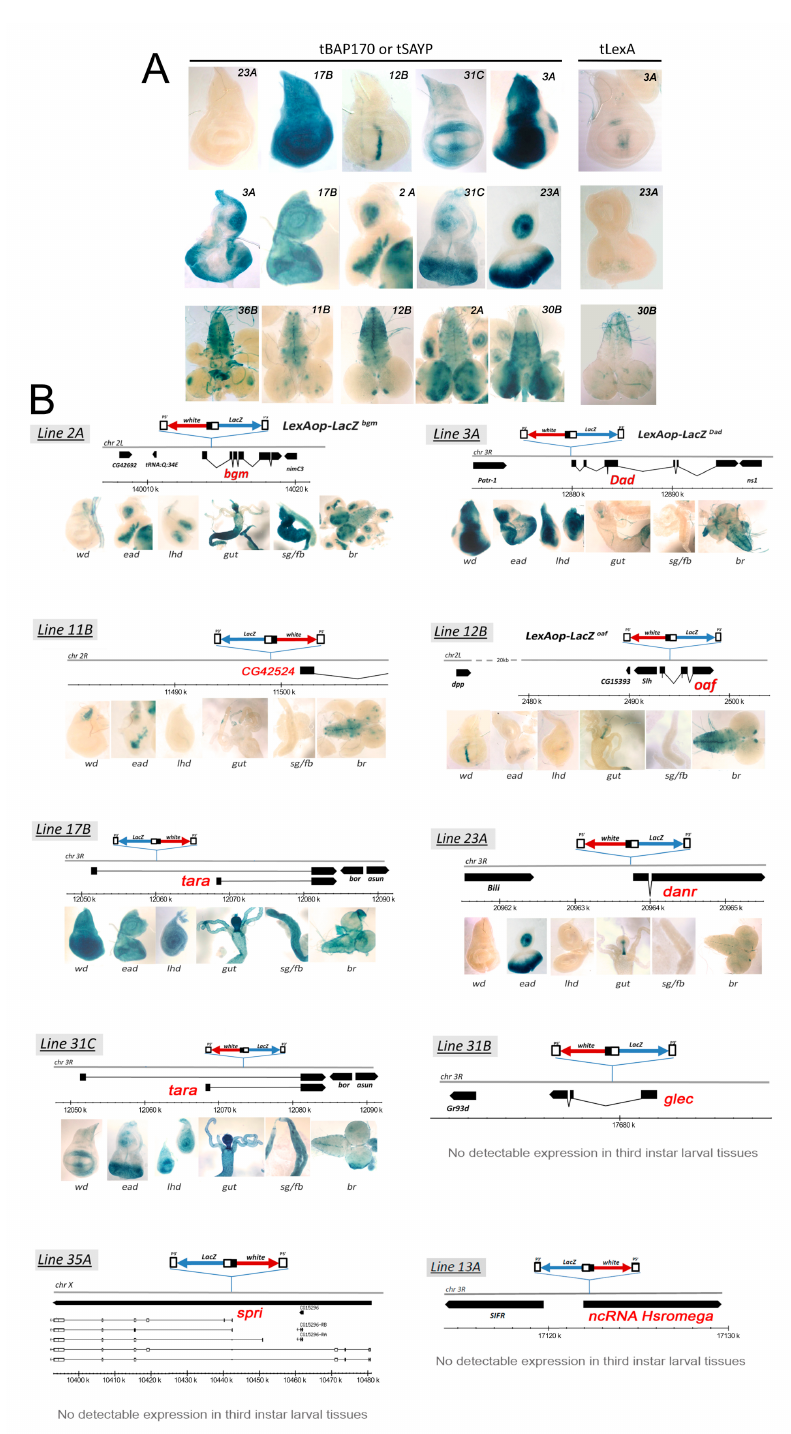
Figure 2. Enhancer capture by targeted BAP170/SAYP at the promoters of independent reporter transgenes. ( A ) A detailed view of the tissue-specific expression patterns obtained after introducing P tub -LexA:BAP170/SAYP to different independent lines expressing the LexAop-LacZ responder element in the wing discs (top), eye-antennal discs (middle), and larval brain (bottom) of L3 larvae. Note that the expression pattern was danr -like in 23A, tara -like in 17B, dpp -like in 12B, and Dad -like in line 3A. Conversely, no expression was induced by targeting the tLexA protein alone. ( B ) Genomic positions of the integrated LexAop-LacZ elements in the most representative lines are shown together with the corresponding P tub - BAP170-induced LacZ expression patterns in third-instar larval tissues. Wd, wing imaginal discs; ead, eye-antennal imaginal discs; lhd, leg-haltere discs; g, guts; sg/fb, salivary glands/fat bodies; br, larval